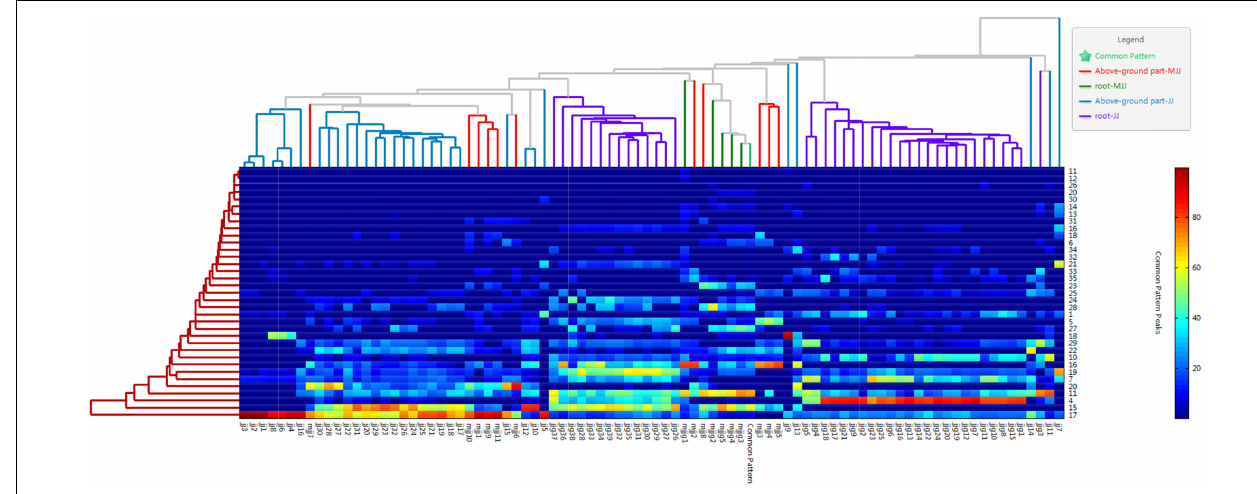
FIGURE 6 | Heat maps of different medicinal parts (above-ground parts and roots) of chicory.